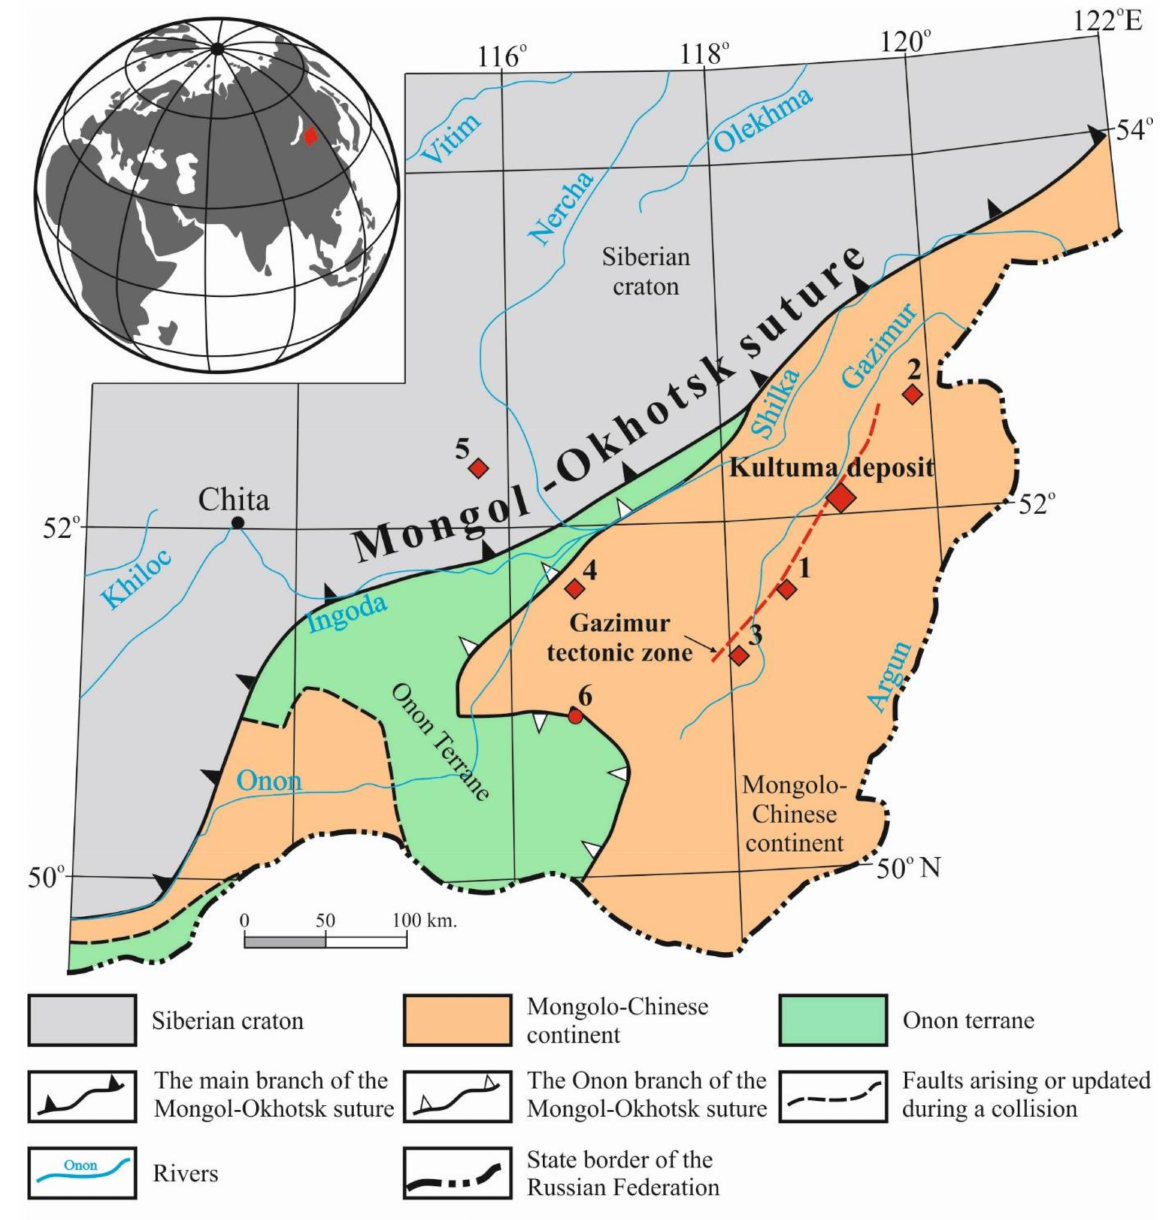
Figure 1. Regional tectonic map of Eastern Transbaikalia (simplified from